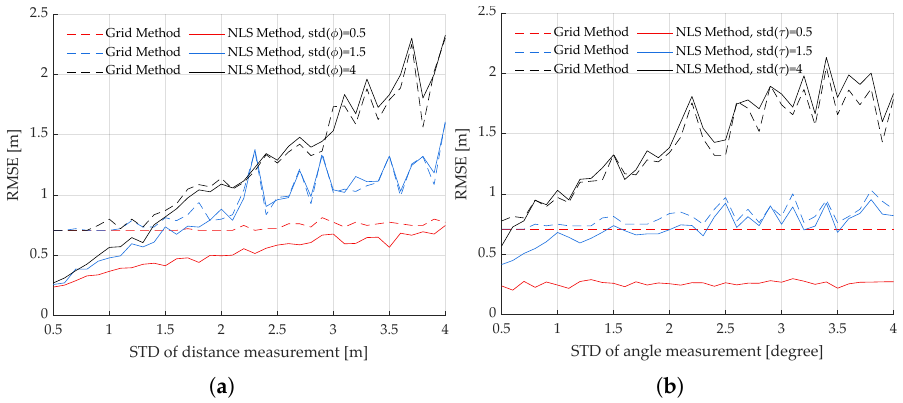
Figure 9. RMSE of localization versus STD of the measurement: ( a ) RMSE versus distance measure- ment; ( b ) RMSE versus angle measurement.